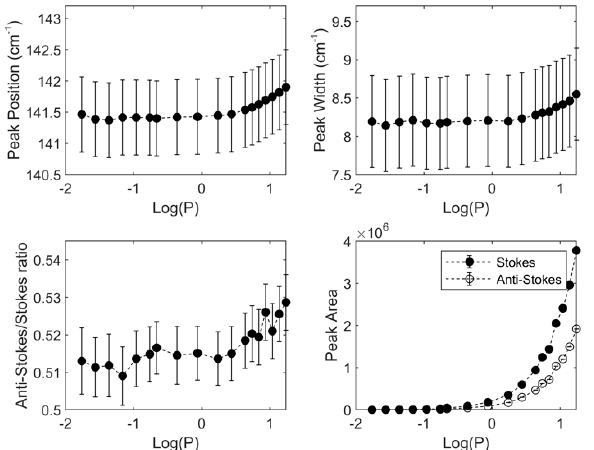
Figure 5. Peak position, peak width, anti-Stokes/ Stokes ratio and peak area for the 143 cm − 1 E g mode of anatase as function of the laser power incident on the sample; λ exc = 514.5 nm. The dashed lines are only for eyes guidance. All data are reported against the laser Power (mW) in a logarithmic scale. It is evident that parameters are not increasing with the laser power only in the small range, 0–2 mW, while at higher input power they increase with the increase of the laser